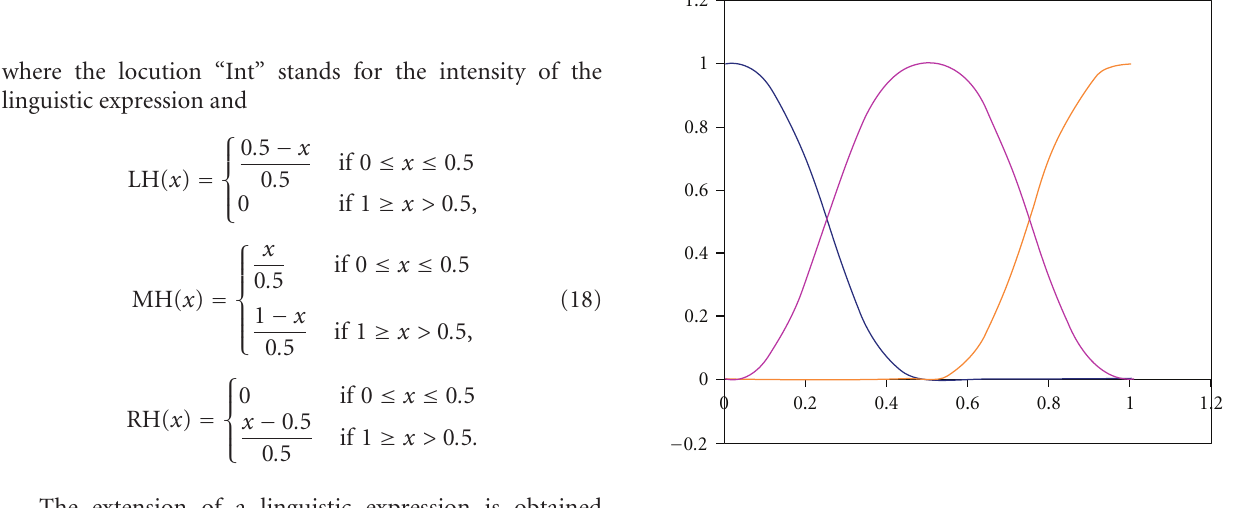
Figure 6: The functions LH, MH, and RH.